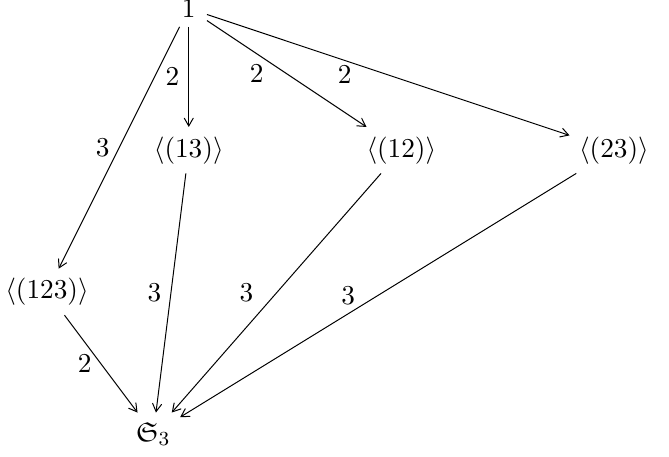
Figure 3 . The duality group action on the three vacua of the su (2) N = 1 (cid:3) theory. The action of T on the complexi(cid:12)ed coupling is indicated in green, the action of S in red.